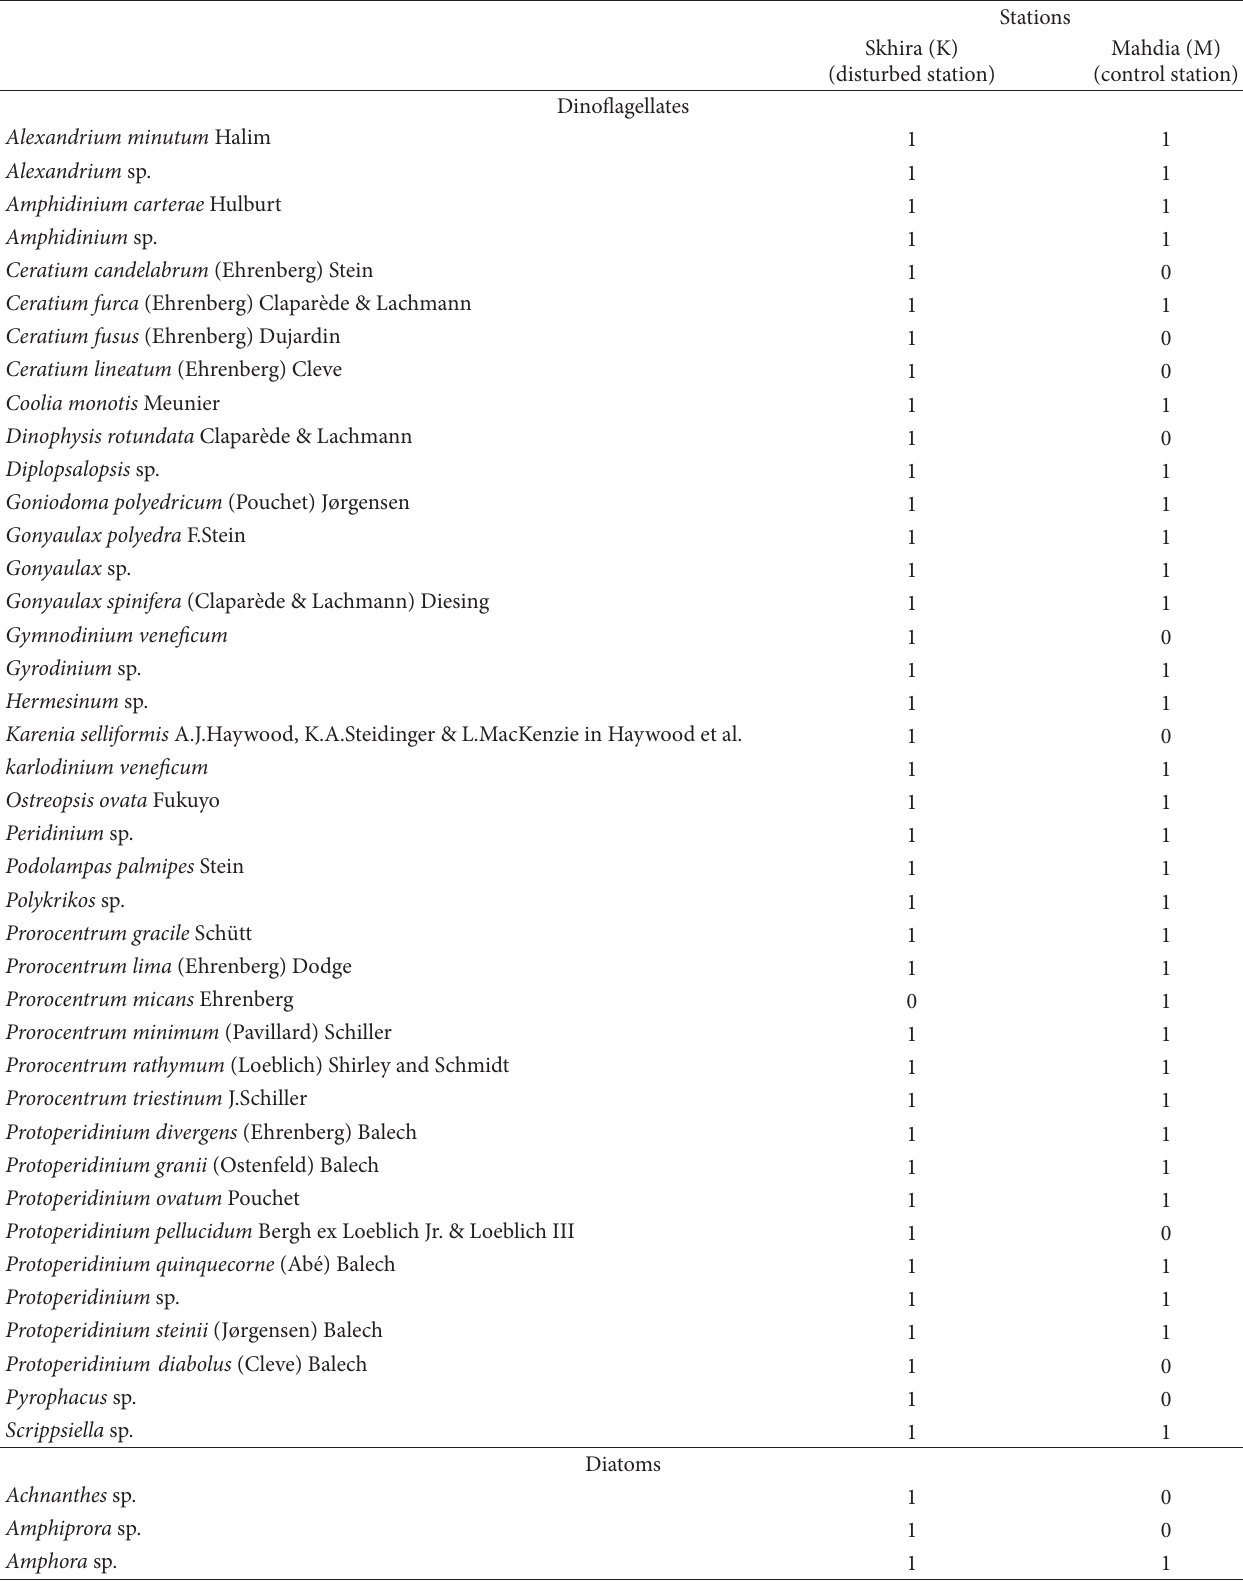
Table 2: Presence-absence species list of planktonic microalgae identified in prospected